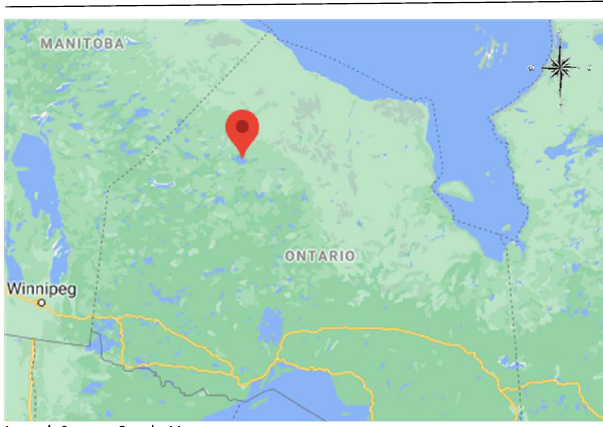
Legend : Source, Google